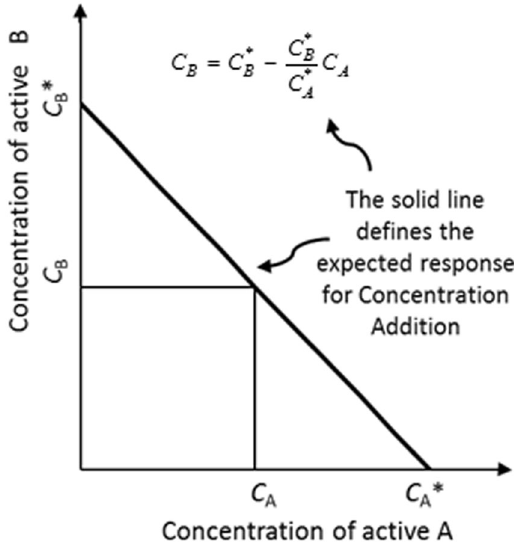
Figure 5. Illustrating the concept of Concentration Addition (CA) with an isobologram for a binary mixture of active agents. C A * and C B * correspond to the concentrations at which application of agents A and B lead to a specific effect, e.g. LC 50 in toxicology. The straight line defines the expected effect for concentration